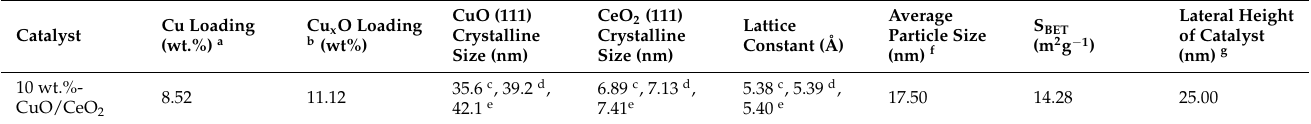
Table 2. Textual and physicochemical properties of the